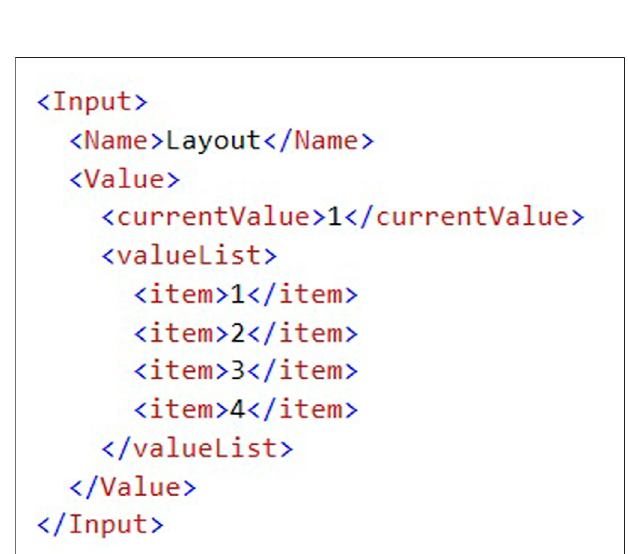
FIGURE 5 | Description of a user-de fi ned parameter as an entry in the input. xml fi le.